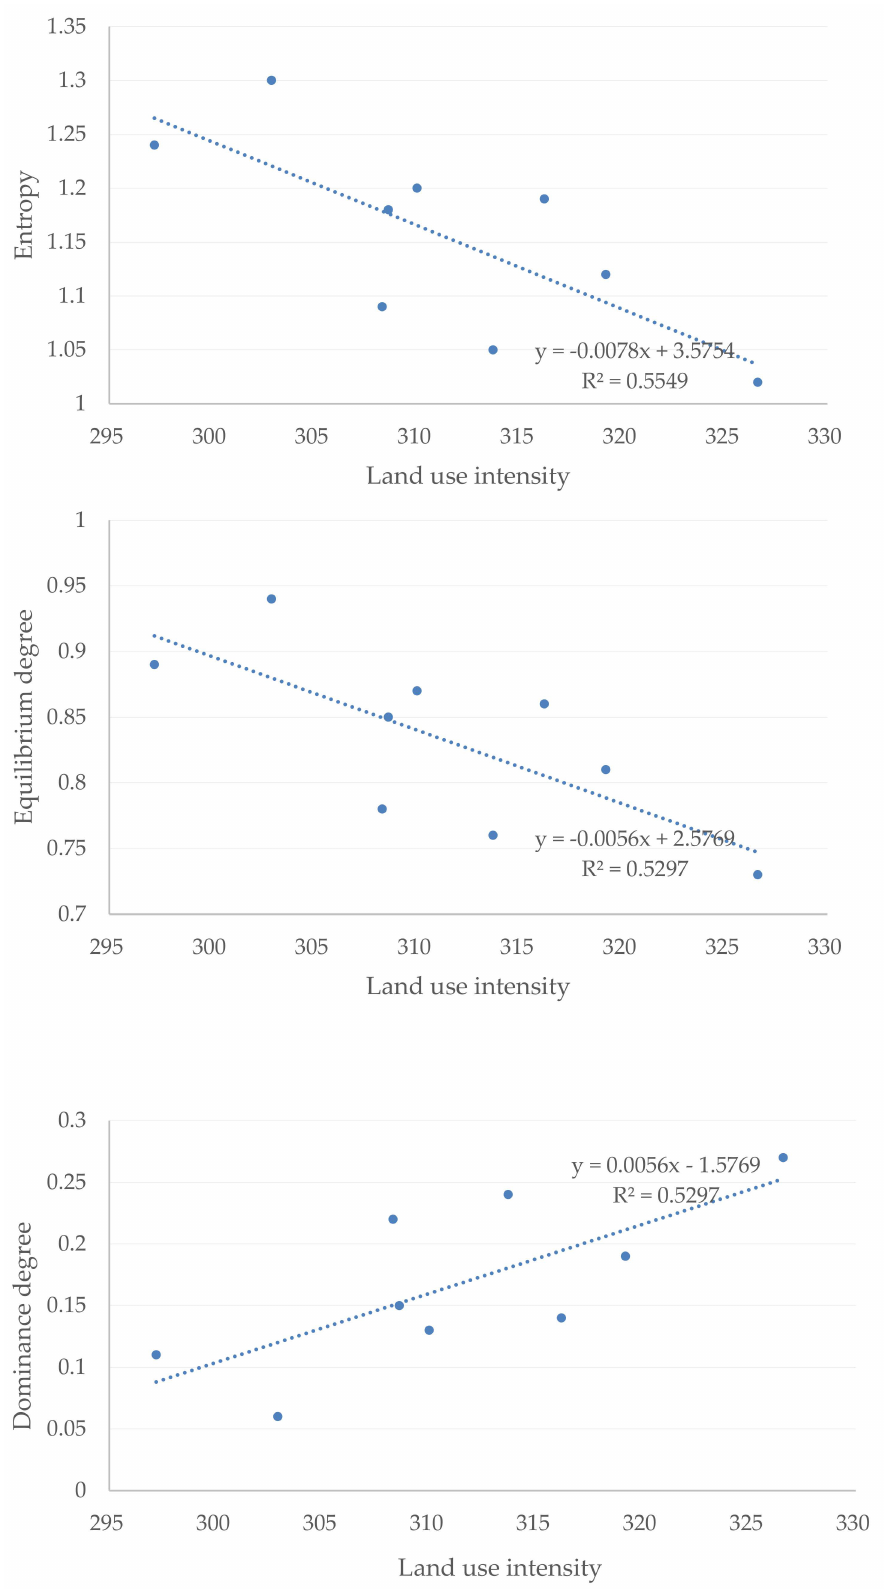
Figure 11. Fitting of the correlation between land-use intensity and entropy, equilibrium degree, and dominance